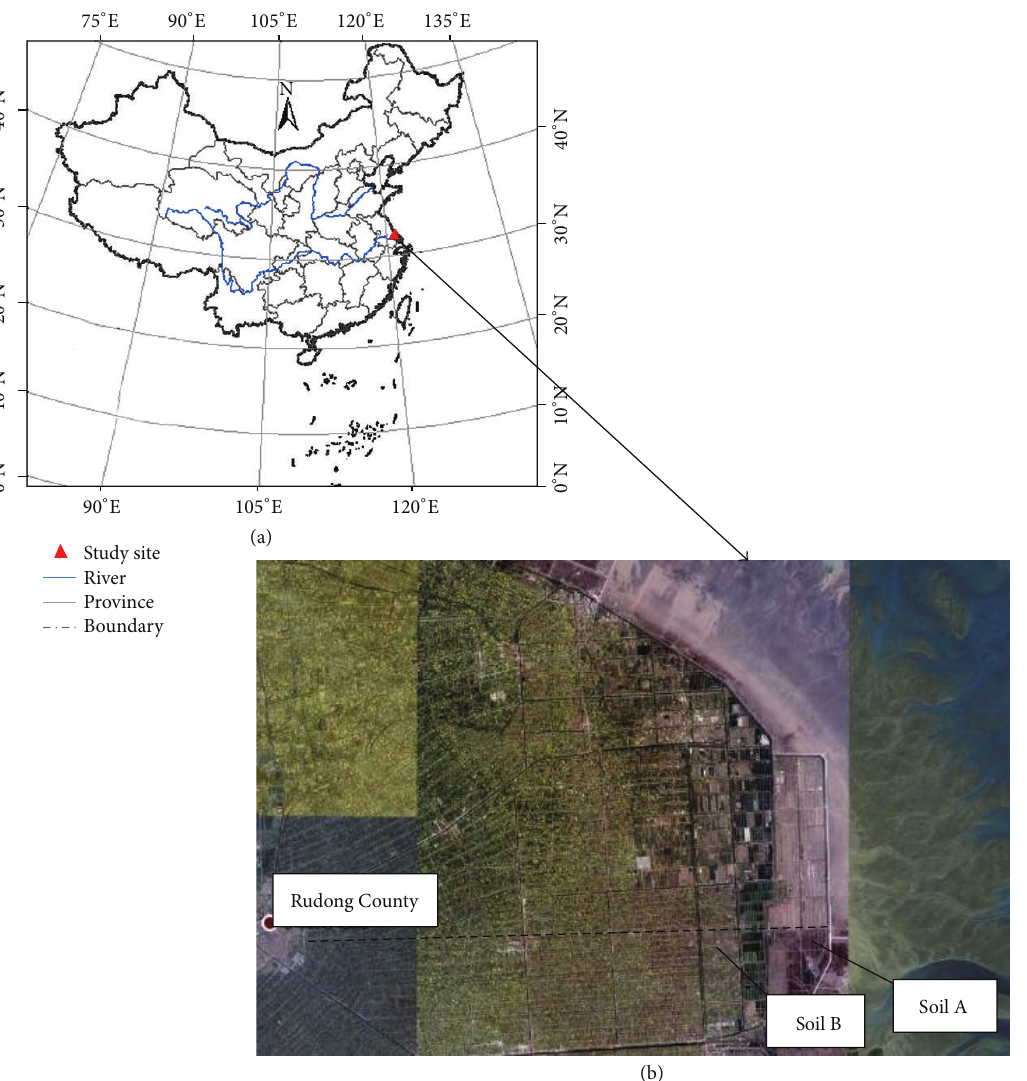
Figure 1: Location of the study site in Jiangsu Province, China (a) and of the two soil collection sites that were reclaimed in different years (b) (Soil A: 2007; Soil B: